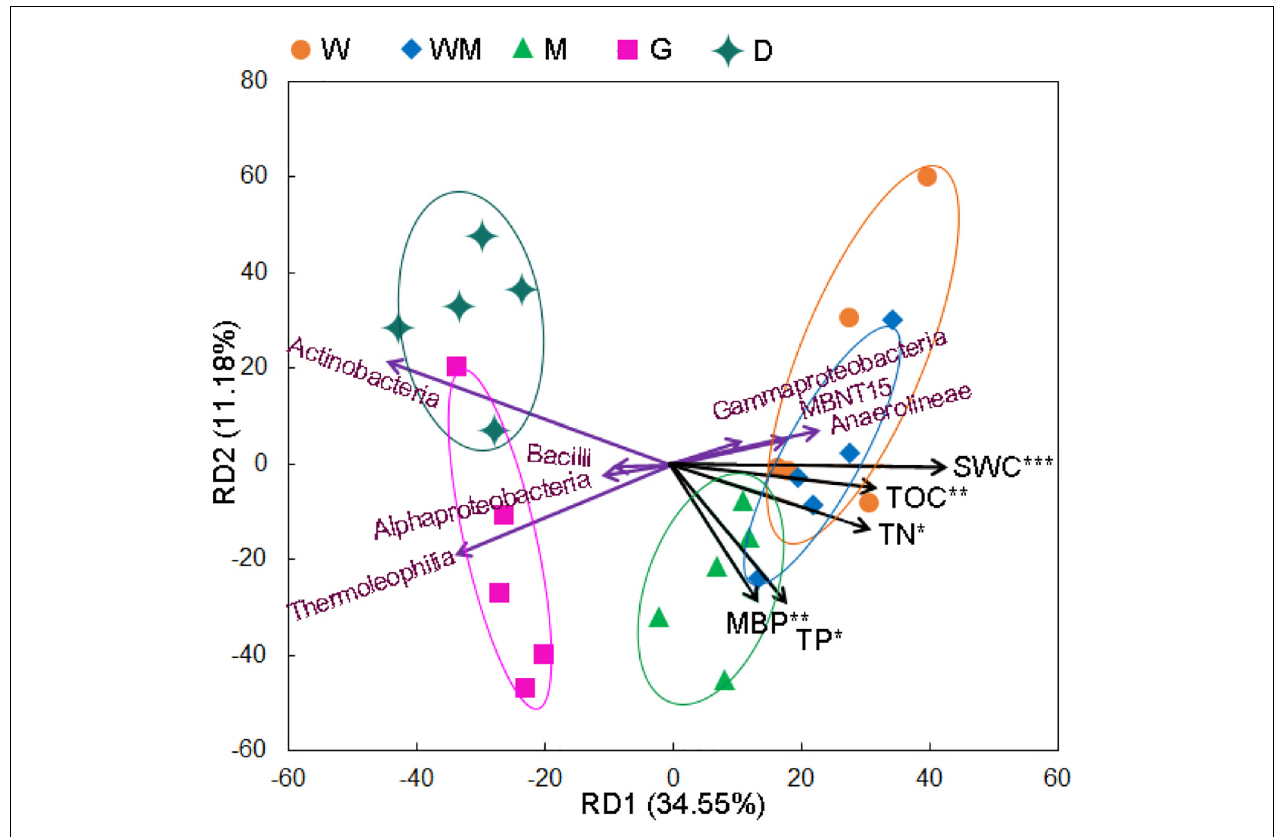
FIGURE 5 | Redundancy analysis (RDA) of the multivariate relationships among soil properties and microbial classes along degradation gradients (W, typical wetland; WM, wet meadow; M, meadow; G, grassland; D, desert). MBP, microbial biomass phosphorus; SWC, soil water content; TP, total phosphorus; TOC, total organic carbon; TN, total nitrogen. *, **, and *** represent significant correlation at P < 0.05, P < 0.01, and P < 0.001, respectively.